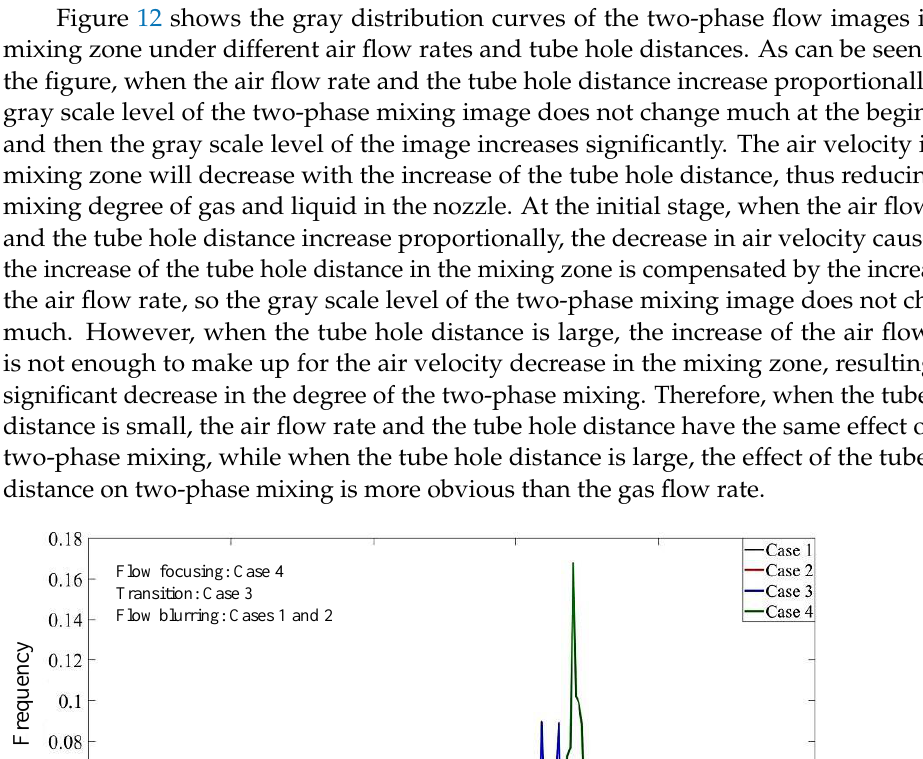
Figure 11. The gray distribution curves of the two-phase flow images under different air and water flow rates: the tube-hole distance and orifice diameter are 1 mm and 5 mm. Based on case 1, the air and water flow rates in cases 1 to 4 can be dimensionless into (in the form of air flow rate/water flow rate):1/1, 1.5/1.5, 2/2 and 2.5/2.5.